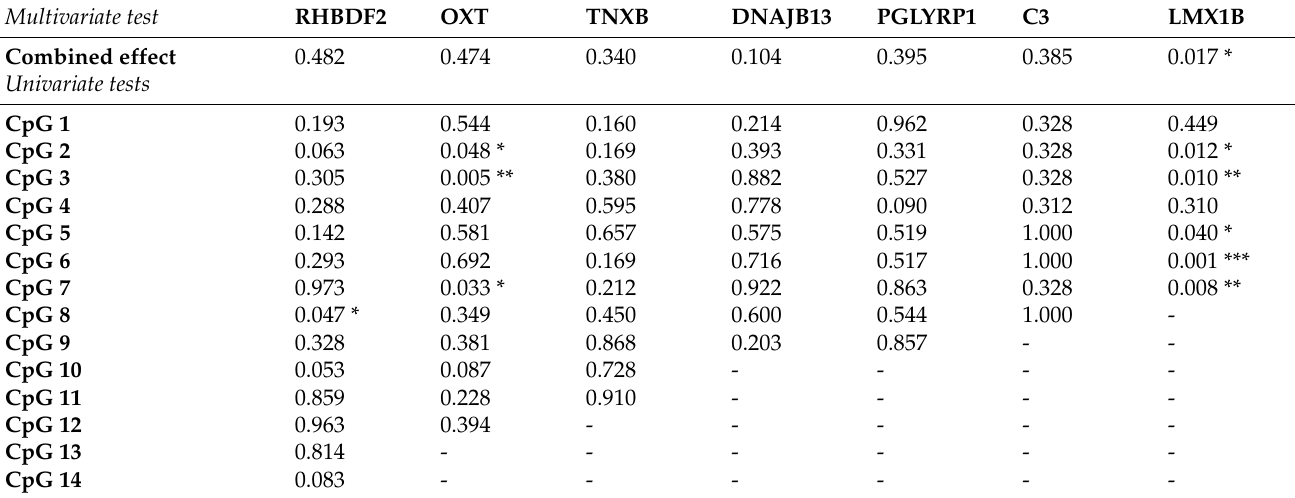
Table 2. One-way repeated measures multivariate analysis of variance